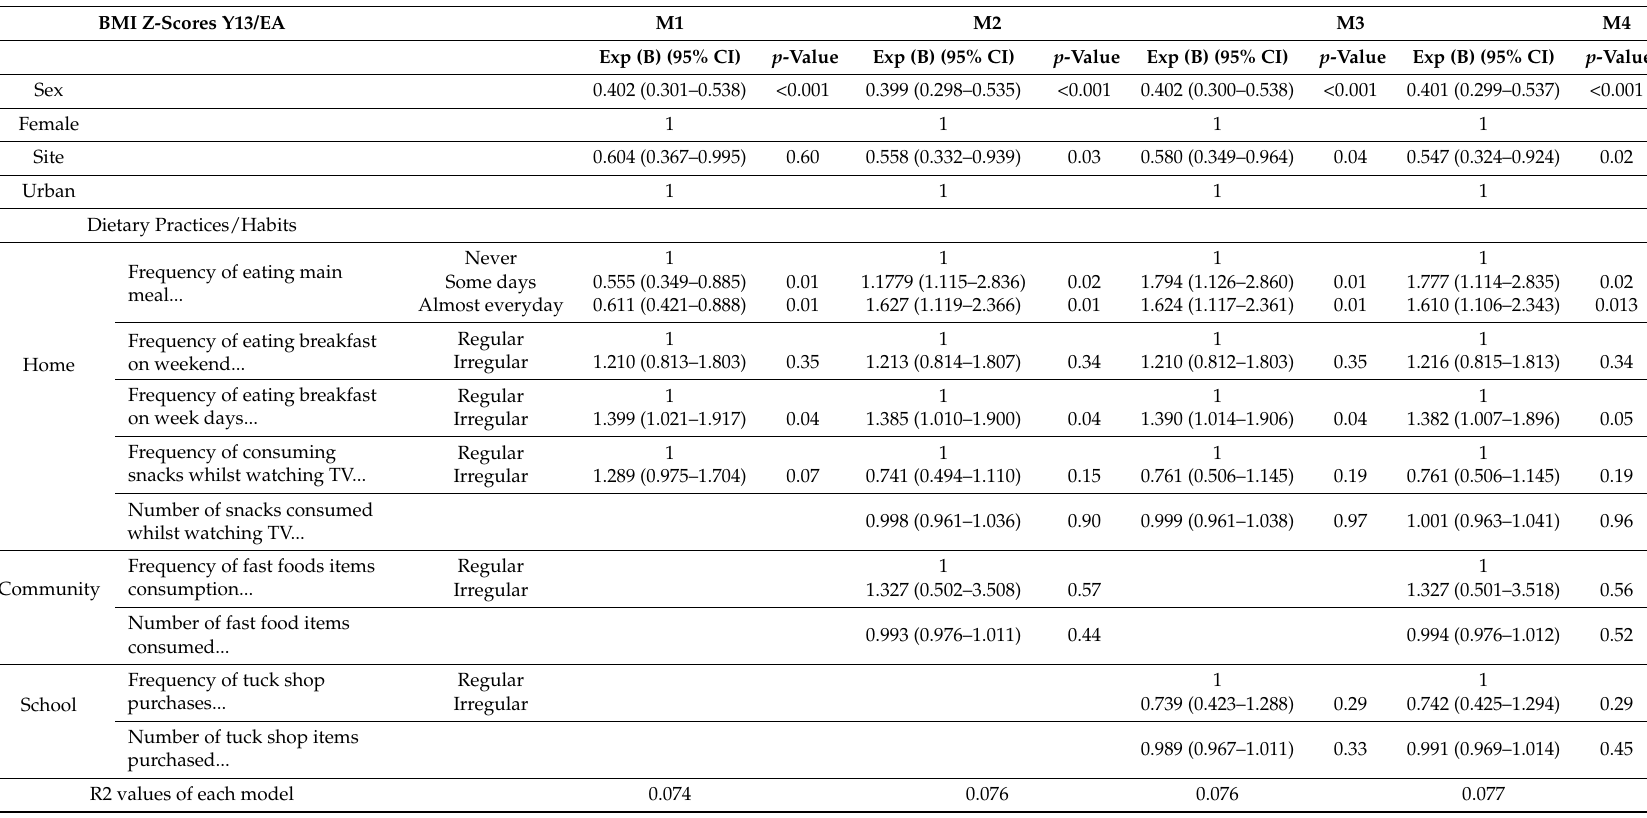
Table 5. Multiple logistic regression analysis for risk of being overweight or obese (BMI for age Z-scores cut offs), gender, site and dietary